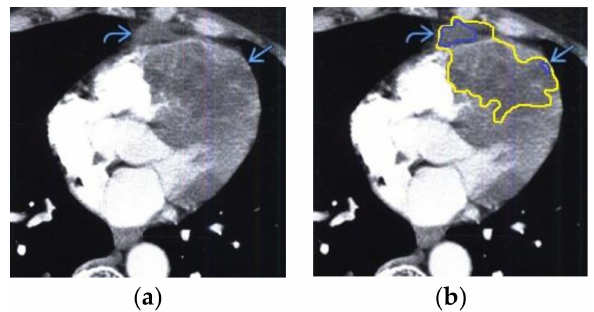
Figure 5. Heart MRI: ( a ) image with white noise and ( b ) denoised image with contrast enhancement of volume melanoma in the left atrium.